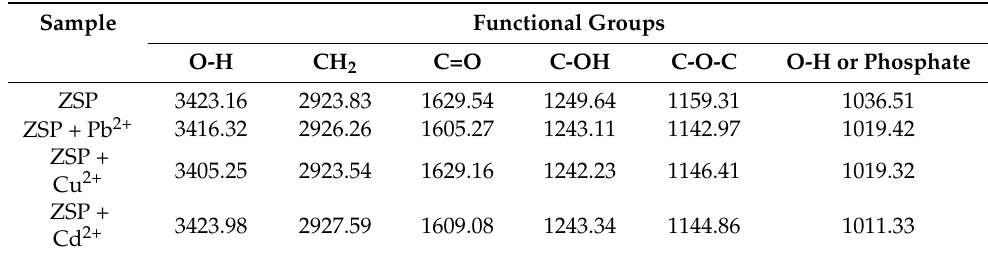
Table 3. Wave numbers (cm −1 ) of dominant peaks obtained from FT-IR transmission spectra of ZSP + Pb 2+ , Cu 2+ , Cd 2+ .